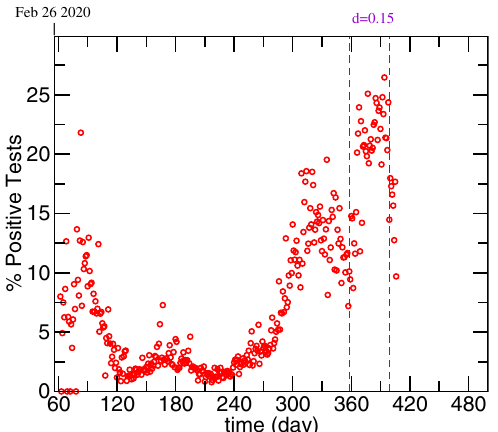
Figure 2. Evolution of the percentage of positive test in